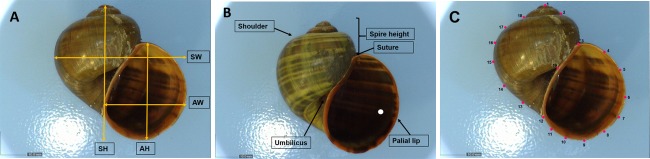
Shell characters used for morphological analysis.(A) Quantitative measurements obtained from aperture view of the shell: shell width (SW), aperture width (AW), aperture height (AH) and shell height (SH). (B) Shell qualitative characters (See Table 1 for details). (C) The location of 19 landmarks used in geometric morphometric analysis of shell shape.